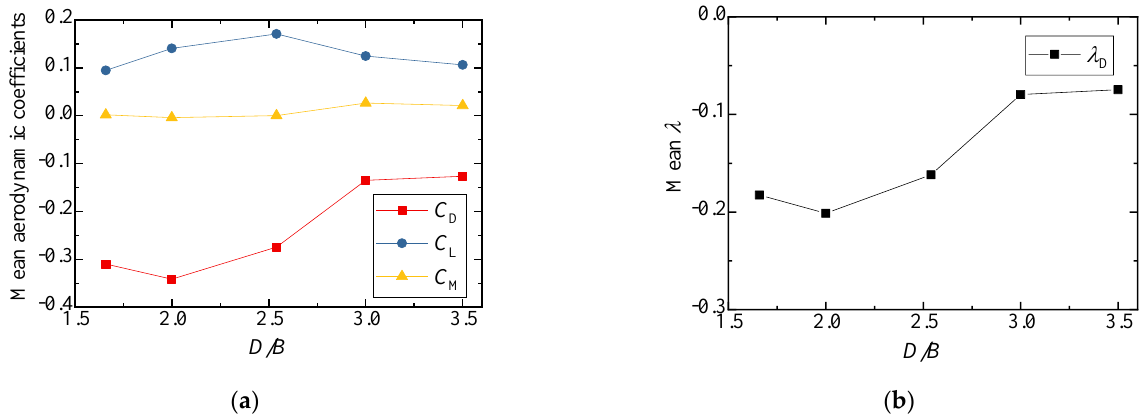
Figure 12. Comparison of the ( a ) aerodynamic coefficients and ( b ) interference factor downstream of the bridge for various D/B ratios in Case 2.